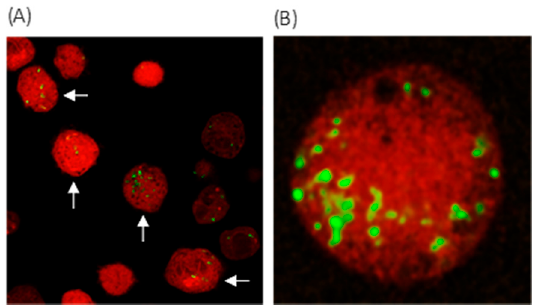
Figure 1. Confocal microscopy image of C. acnes infected KB7007NP disc cells (arrows) [multiplicity of infection (MOI) 1:1000; 48 h, original multiplication x40] ( A ). Fluorescently labelled C. acnes (green) were visible as intracellular clusters, and individual bacteria within viable Calcein Red-Orange-stained disc cells derived from NP tissue ( B ).